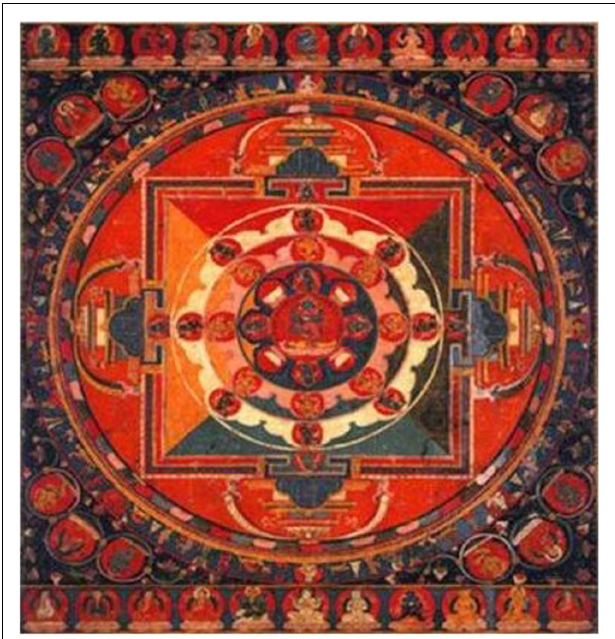
FIGURE 1 | An example of Mandala. ( Figure 2 ). In his pioneering neuroevolutionary contributions,